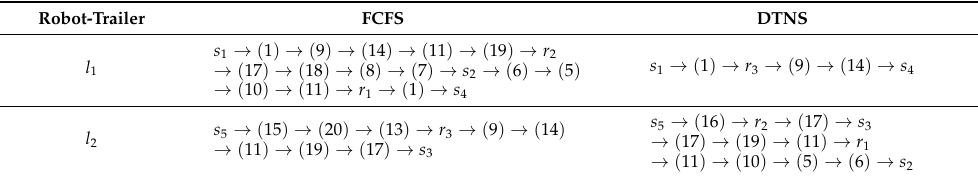
Table 8. Paths obtained by FCFS and DTNS under the condition of two robot-trailer in scenario 1.